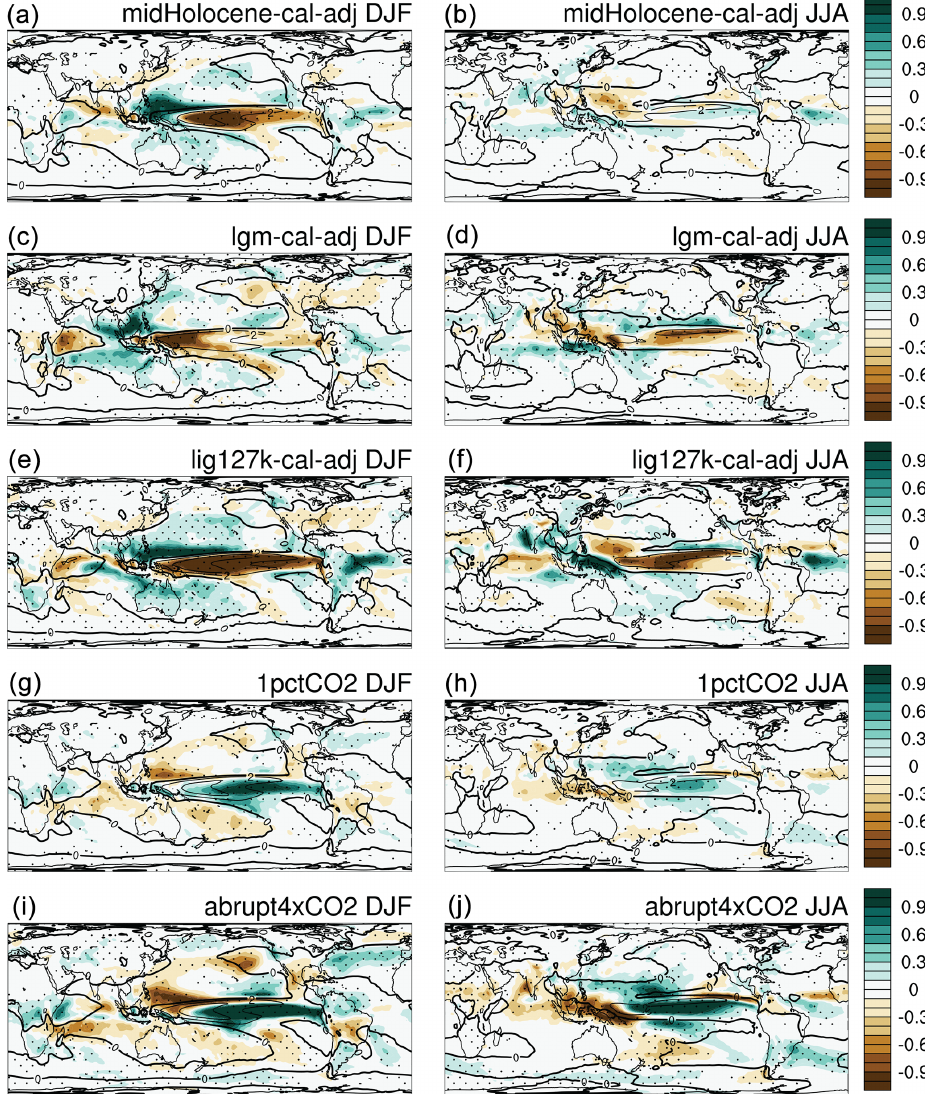
Figure 12. The changes in the seasonal precipitation teleconnection pattern associated with ENSO in each experiment compared with the pre-industrial control. The ensemble mean difference between the precipitation composites of each model’s El Niño minus La Niña (defined as ± 1 standard deviation) in the (a, b) midHolocene , (c, d) lgm , (e, f) lig127k , (g, h) 1pctCO2 , and (i, j) abrupt4xCO2 experiments minus the same pattern for the piControl simulations is shown. The ensemble mean ENSO patterns in the piControl simulations are shown as black contours. Stippling indicates that more than two-thirds of the ensemble members agree on the sign of the